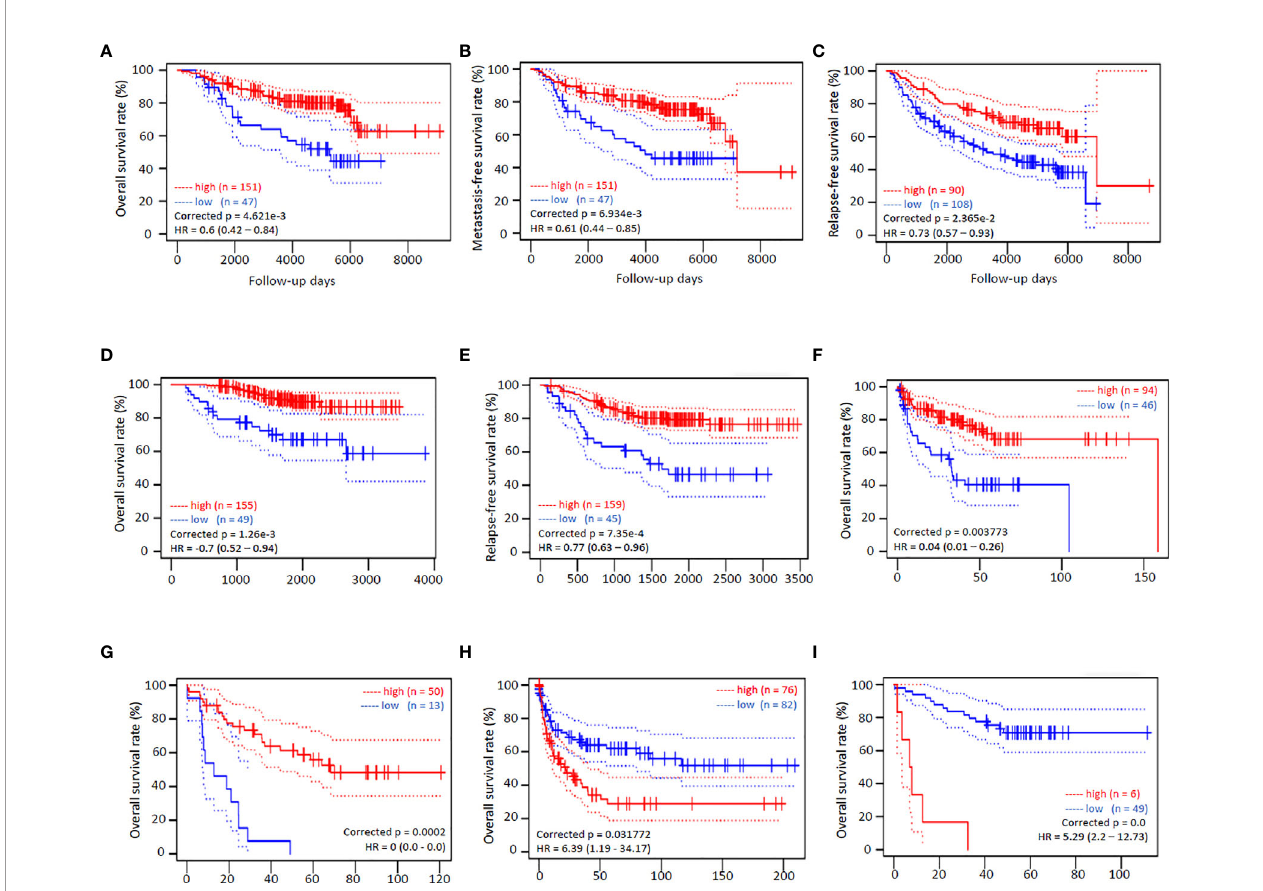
FIGURE 3 | NR0B2 expression is signi fi cantly associated with patient survival in multiple human cancers. Kaplan-Meier plots were generated on the PrognoScan platform (19). NR0B2 expression by cDNA microarray analysis in cancer tissues was dichotomized into two groups, high (red) or low (blue), at the optimal cut-point by the minimum p -value approach (19). Survival curves were plotted as solid lines with 95% con fi dence intervals for each group by dotted lines. Correct p and HR values (95% CI) are inserted in the plots. (A – C) NR0B2 expression with HG-U133A microarray chips in 198 breast cancer cases (GSE7390) (28). (D, E) NR0B2 expression with HG-U133plus2 microarray chip in 204 stage I-II lung adenocarcinoma cases (GSE21210) (29). (F) NR0B2 expression with HG-U133A microarray chips in 140 liposarcoma cases (GSE30929) (30). (G) NR0B2 expression with HG-U133plus2 microarray chip in 63 uveal melanoma cases (GSE22138)